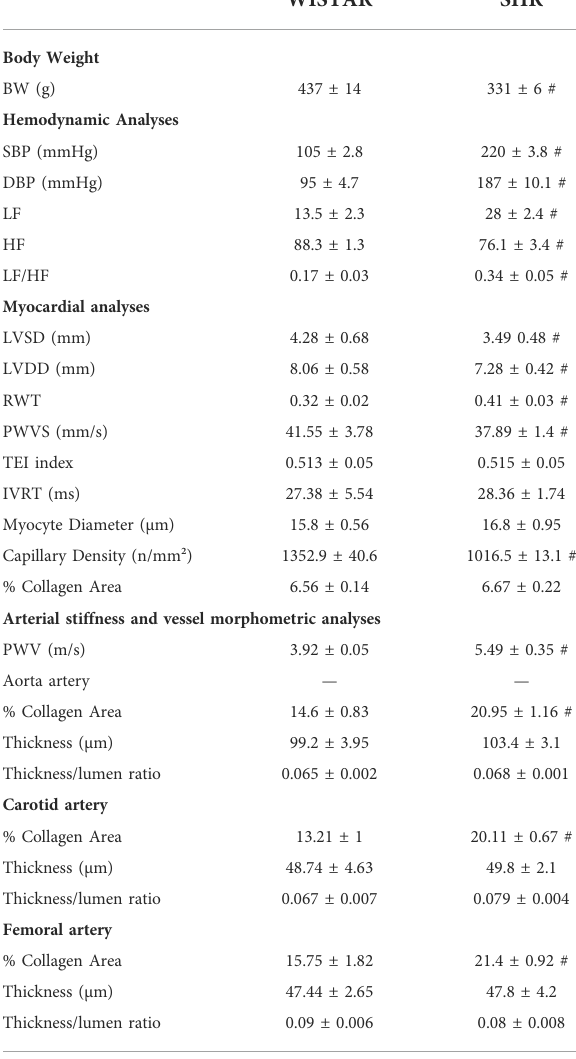
TABLE 1 Comparison of body weight, hemodynamics, cardiac and vascular parameters between hypertensive and normotensive sedentary animals.